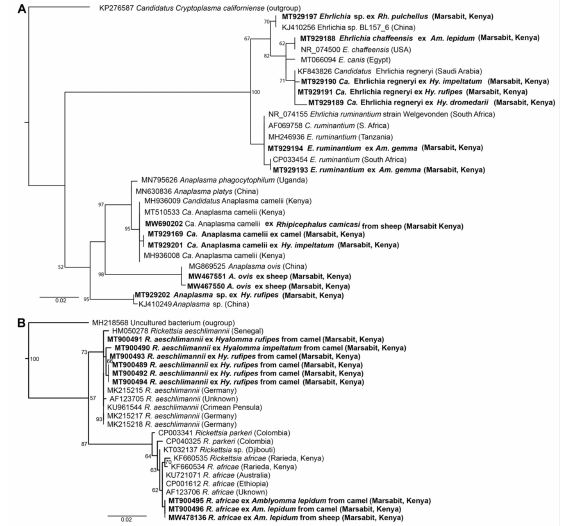
Figure 5. Maximum likelihood phylogenetic trees of ( A ) 1030-bp Anaplasma spp. and 451-bp Ehrlichia spp. 16S rRNA sequences and ( B ) 857-bp Rickettsia spp. ompB sequences. Sequences amplified from blood and ticks infesting camels in northern Kenya in this study are indicated in bold. Bootstrap values at the major nodes are of percentage agreement among 1000 bootstrap replicates. The branch length scale represents substitutions per site. Trees are rooted to outgroup sequences (indicated in brackets; top sequence of each